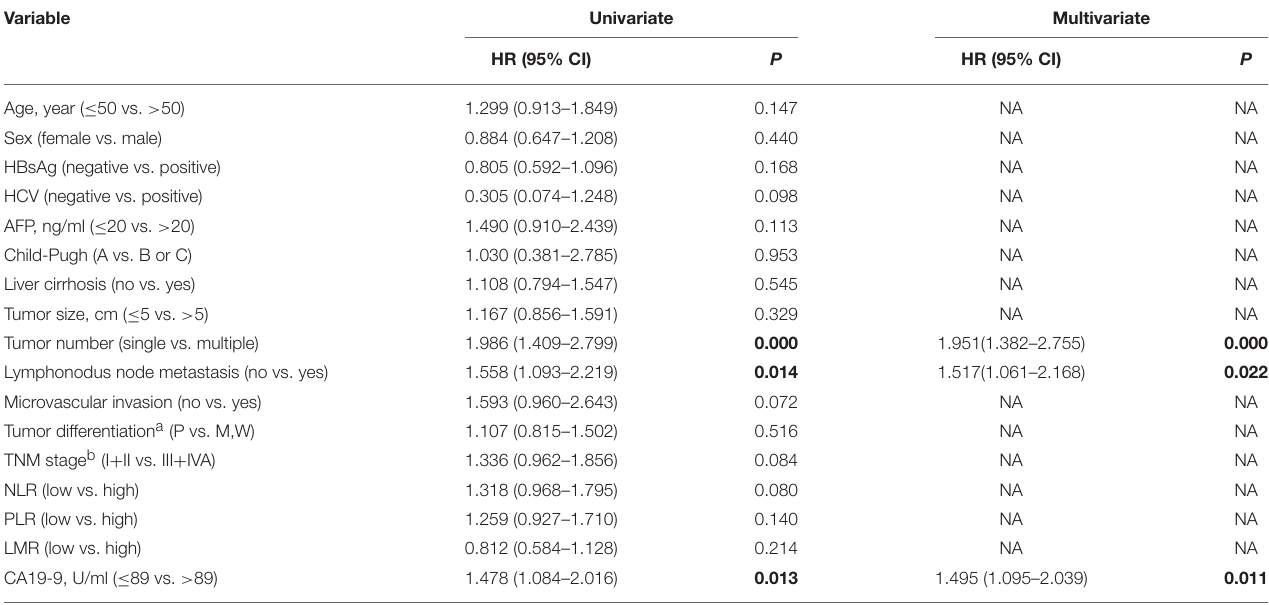
TABLE 2 | Univariate and multivariate cox regression analyses of time to early relapse in patients who were relapse at 2 years after resection with curative intent for intrahepatic cholangiocarcinoma ( n = 168). Variable Univariate Multivariate HR (95% CI) P HR (95%